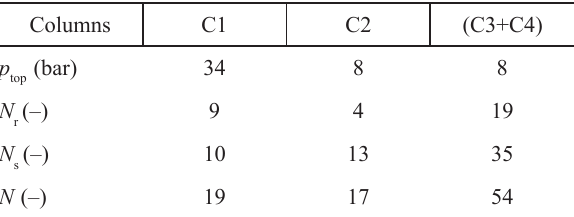
Table 2 – Operating pressures at the top of the columns and corresponding stage requirements for conventional three-col- umn direct sequence, thermally coupled direct sequence (TCDS) and DWC configuration Columns C1